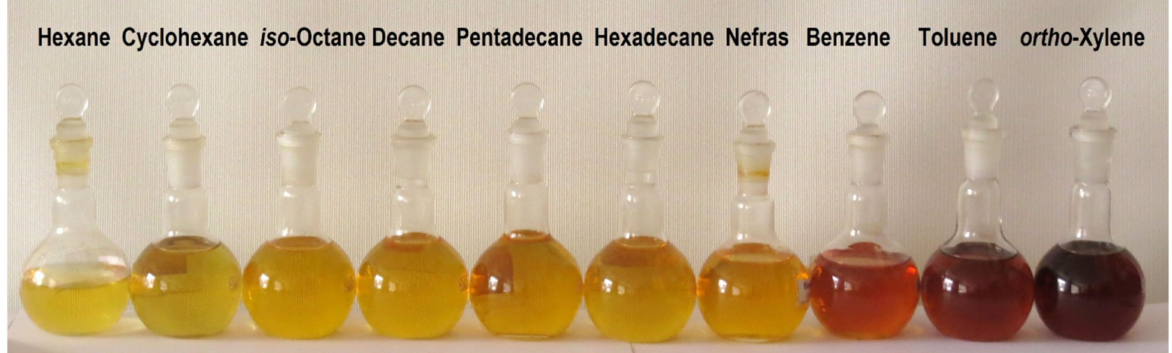
Figure 10. Photos of colored liquid hydrocarbons after treatment by microwave discharge and disposal of solid